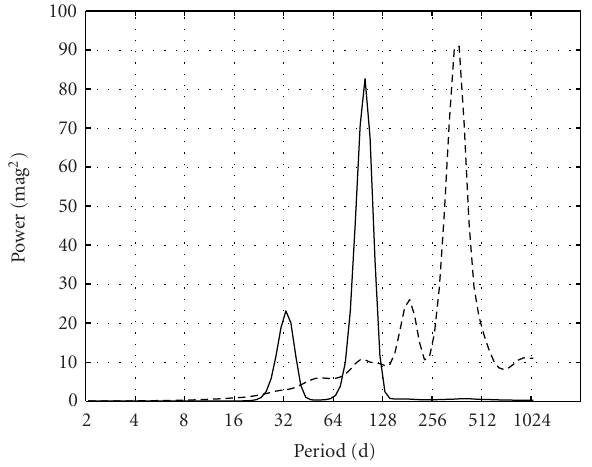
Figure 9: Global wavelet spectrum of the simulated signal made from the AC Herculis sampling (solid line) compared to the GWS from the corresponding sampling signal (dashed line).